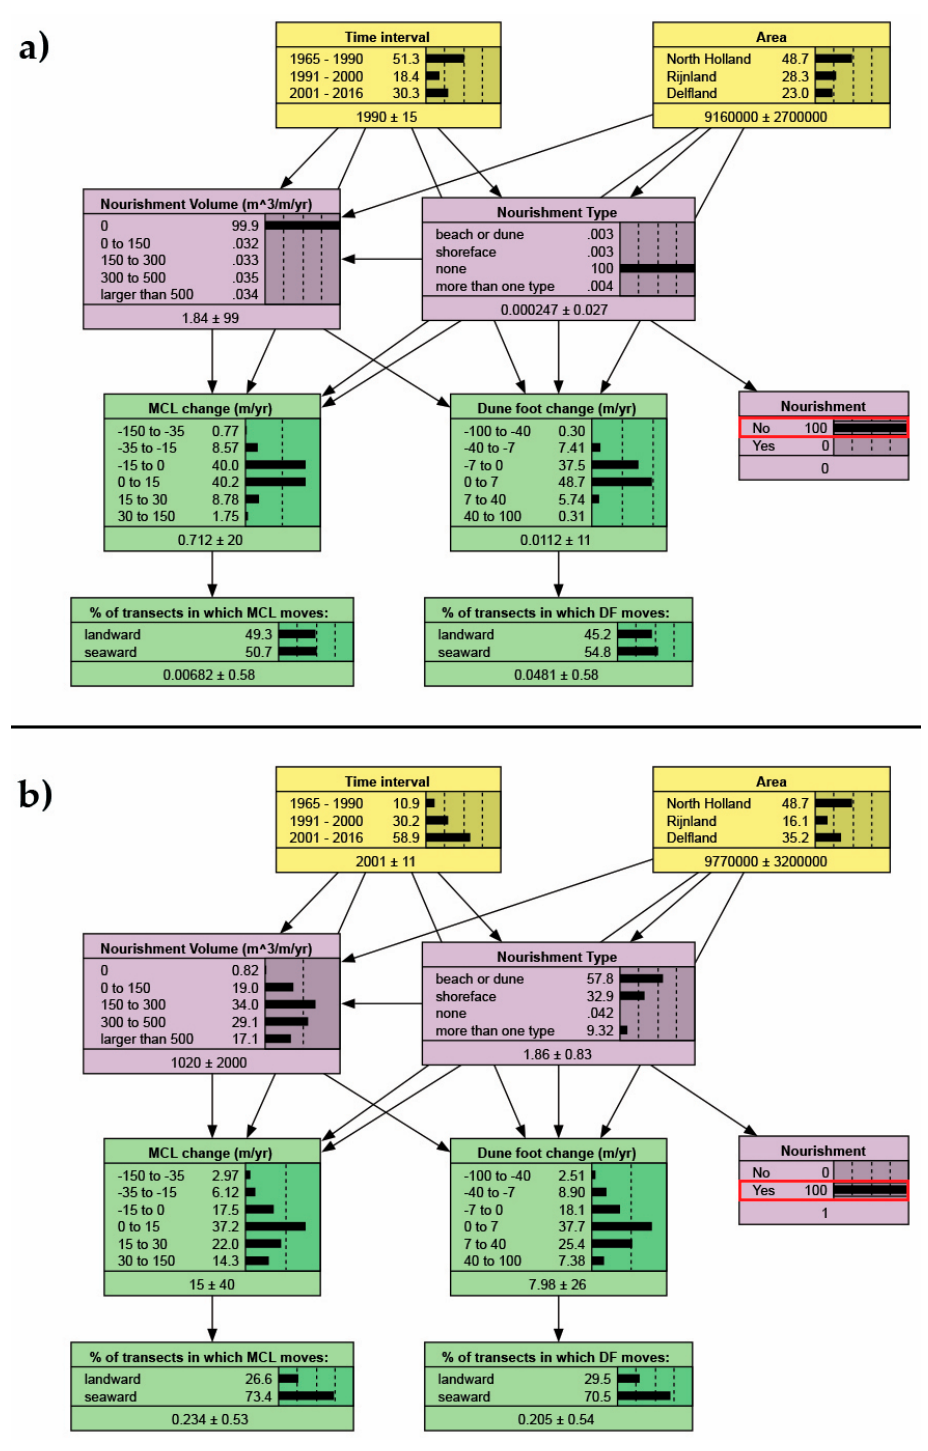
Figure 6. BERM-N application to assess the effectiveness of sand nourishments. Panel above ( a ): BERM-N constrained in order to consider only transects which have not been nourished (see red box). Panel below ( b ): BERM-N constrained in order to consider only transects which have been nourished (see red box).